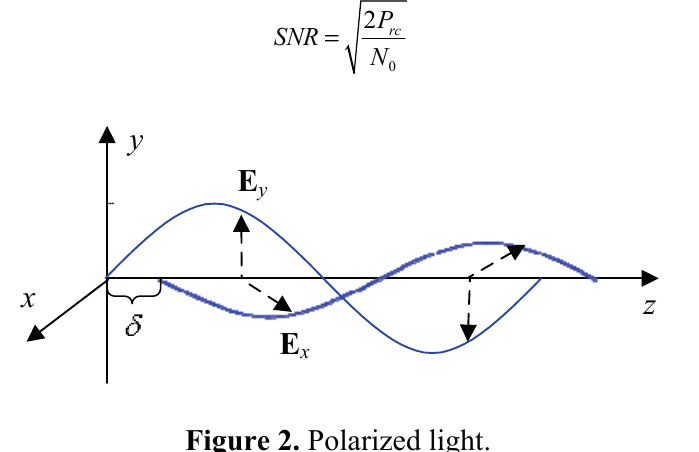
Figure 2. Polarized